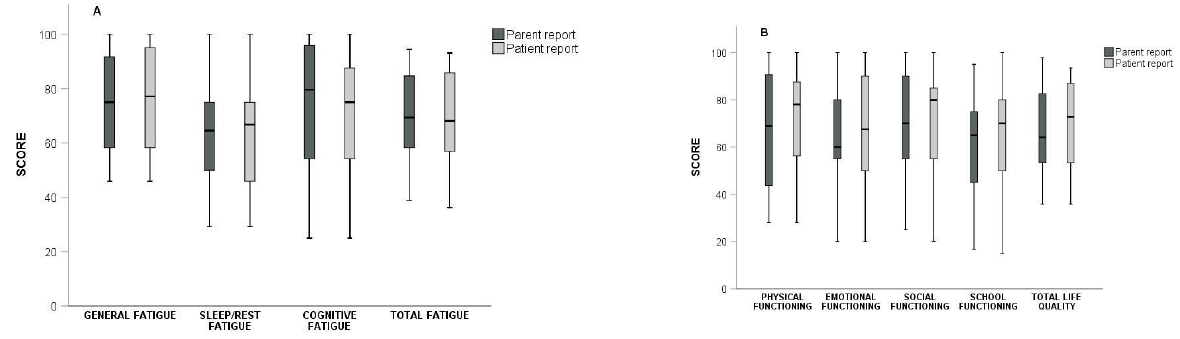
Figure 3. Box plot of patients’ (light gray) and parents’ (dark gray) report scores on ( A ) fatigue and ( B ) health-related quality of life (HRQoL), and their subcategories. Table 2. Correlation between fatigue and health-related quality of life (HRQoL) scores.